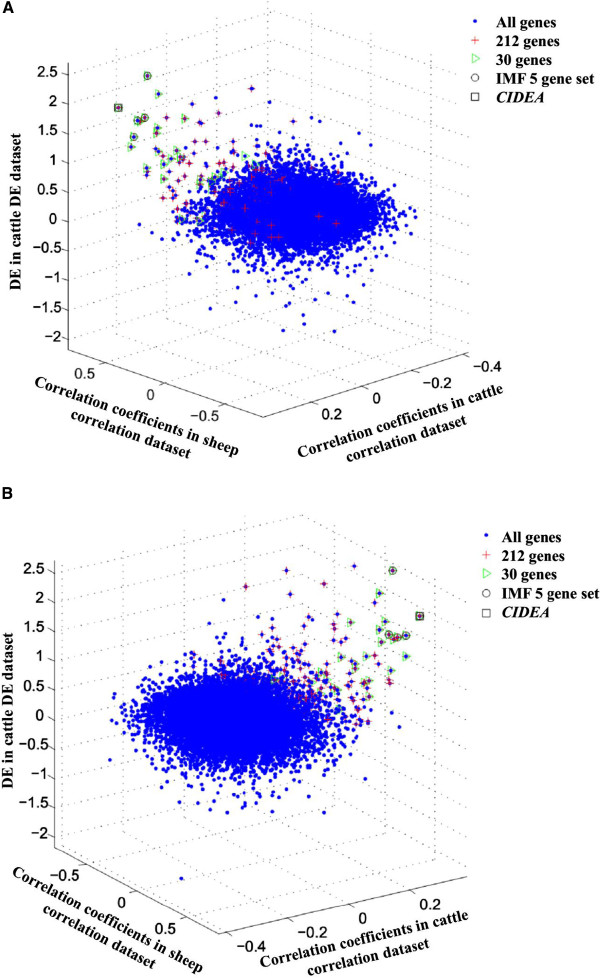
Three dimensional plot of cattle and sheep correlation datasets and cattle DE dataset. Data points for 13,330 probe sets with reliable data in all three datasets. The 212 genes with expression positively correlated with IMF% generated from cattle correlation and DE datasets in our previous study [4]. A) and B) are two different visual angles of this three dimensional plot.